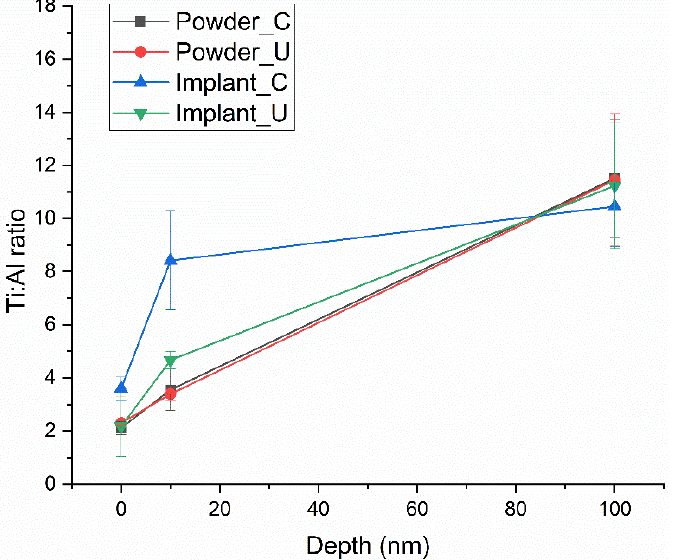
Figure 2. Ti/Al ratio average of the four experimental conditions, showing a significate difference at 10 nm for Implant_C. 10 nm for